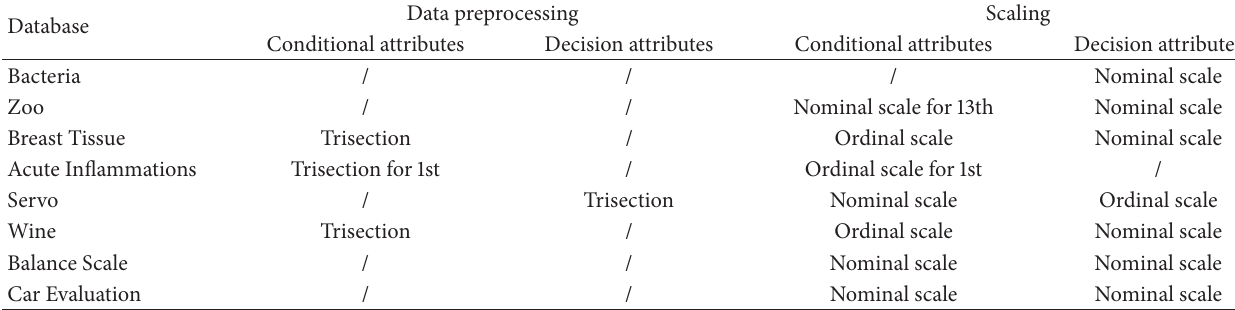
Table 3: Converting the eight chosen databases into formal decision contexts.